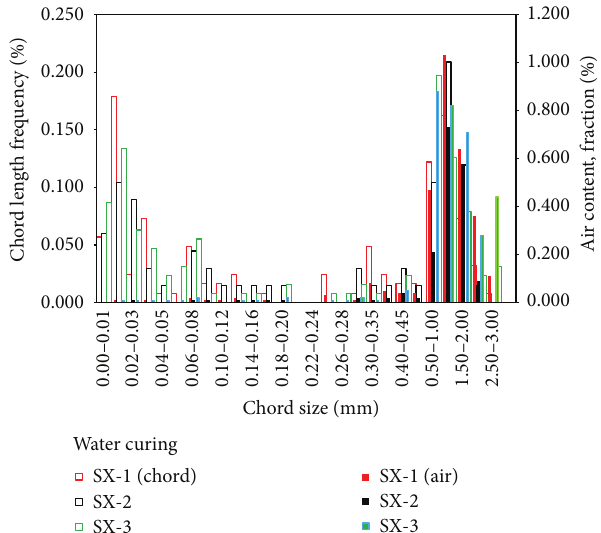
Figure 2: Bubbles normal distribution curves of samples curing in water.